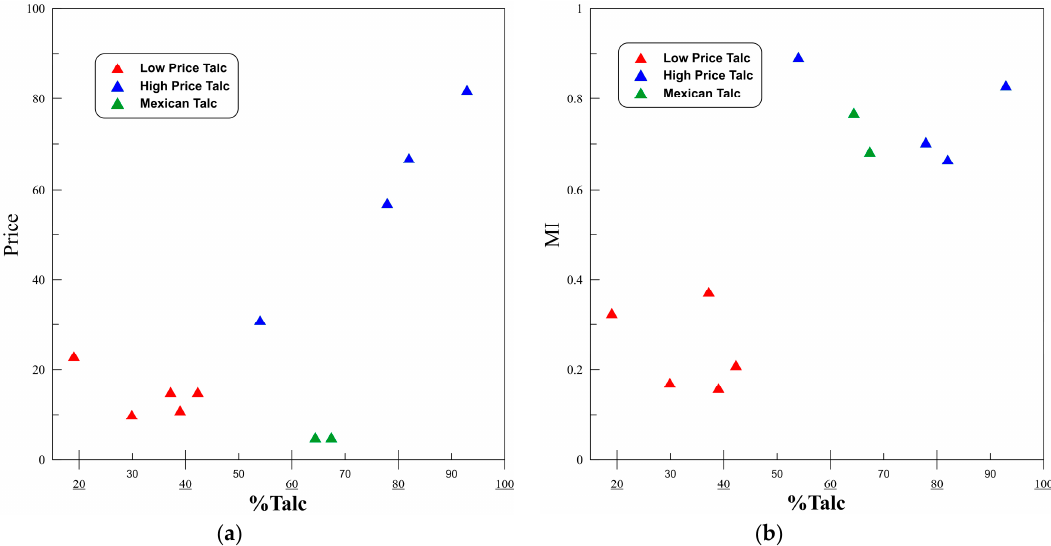
Figure 4. Correlation between price ( a ), morphological index (MI) ( b ) and talc concentration in different types of talc.